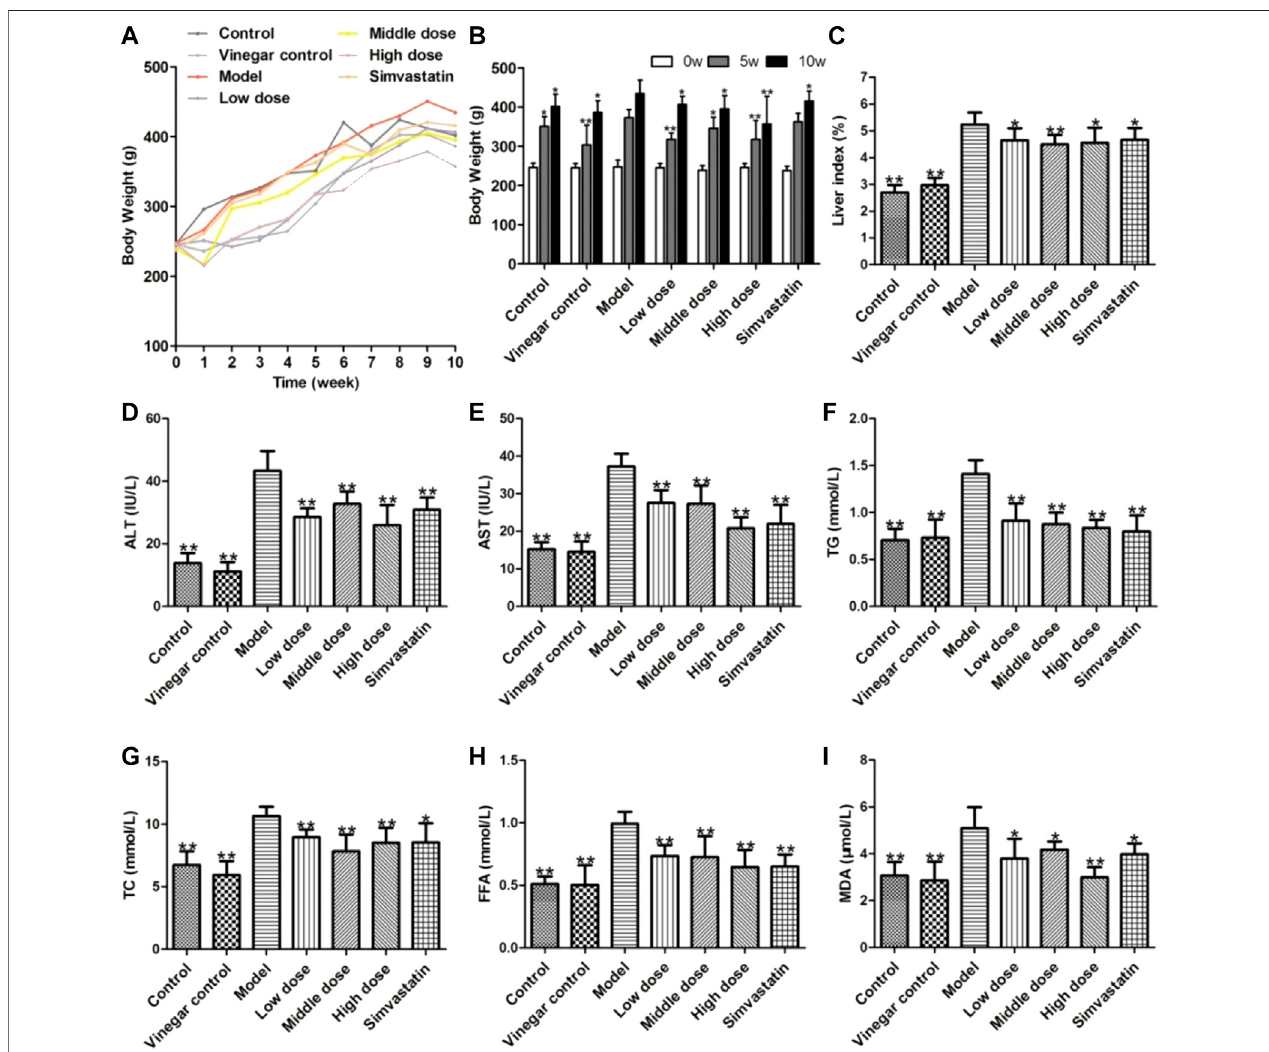
FIGURE2| Effectsofaromaticvinegaronbiochemicalindexesofrats. (A,B) Effectofaromaticvinegaronbodyweight (C) Effectsofaromaticvinegarontheratioof liver to body weight (%); (D – I) Effects of aromatic vinegar on the levels of alanine transaminase (ALT), aspartate transaminase (AST), TG, total cholesterol (TC), and free fatty acid (FFA) in serum and malondialdehyde (MDA) in liver tissue. Values are expressed as the mean ± SD (n (cid:2) 8). * p < 0.05, ** p < 0.01 compared with model groups.